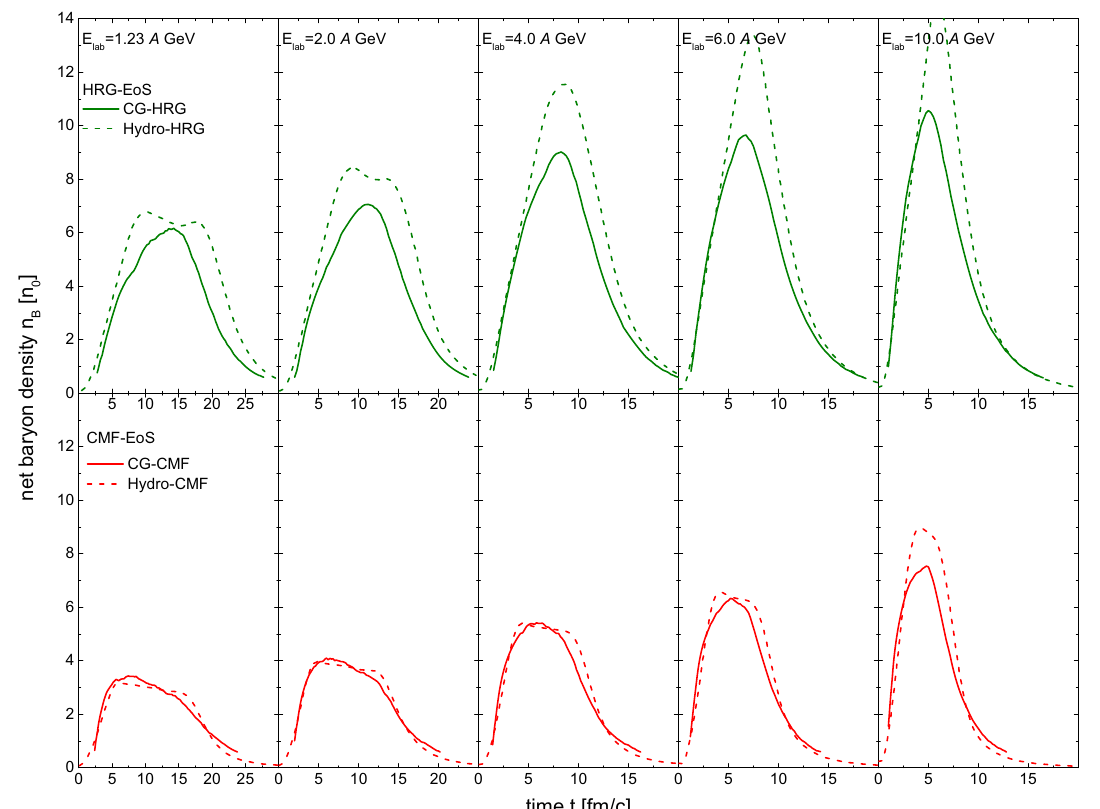
Fig. 3 Time evolution of the baryon density in the central vol- ume of the reaction for central Au+Au reactions at E lab = 1 . 23 , 2 . 0 , 4 . 0 , 6 . 0 , 10 . 0 A GeV (from left to right). The full lines show the results of coarse grained UrQMD simulations and the dashed line shows the results for one-fluid (3+1) dimensional hydrodynamic calcu-